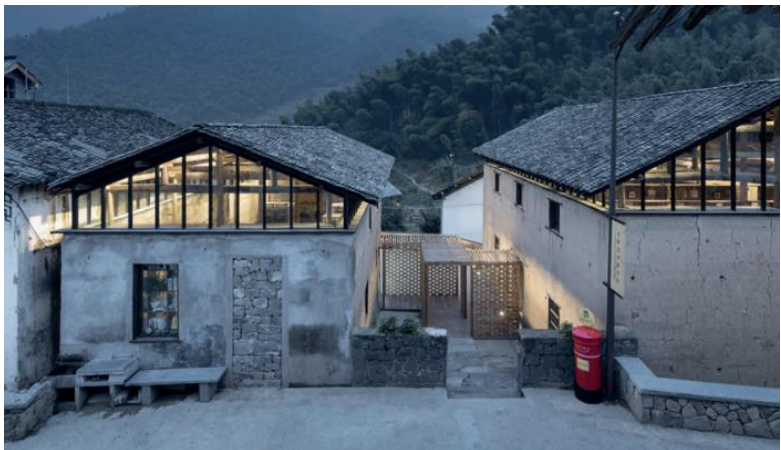
Figure 22. Avant-Garde Ruralization Library (source: [8] ).